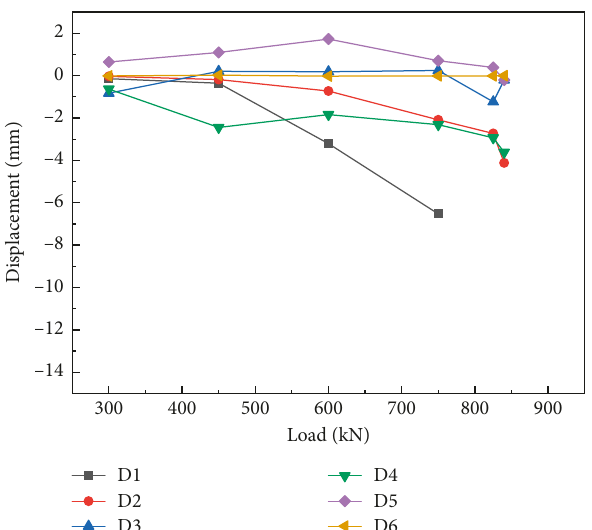
Figure 19: Load-displacement curves in Model 1.